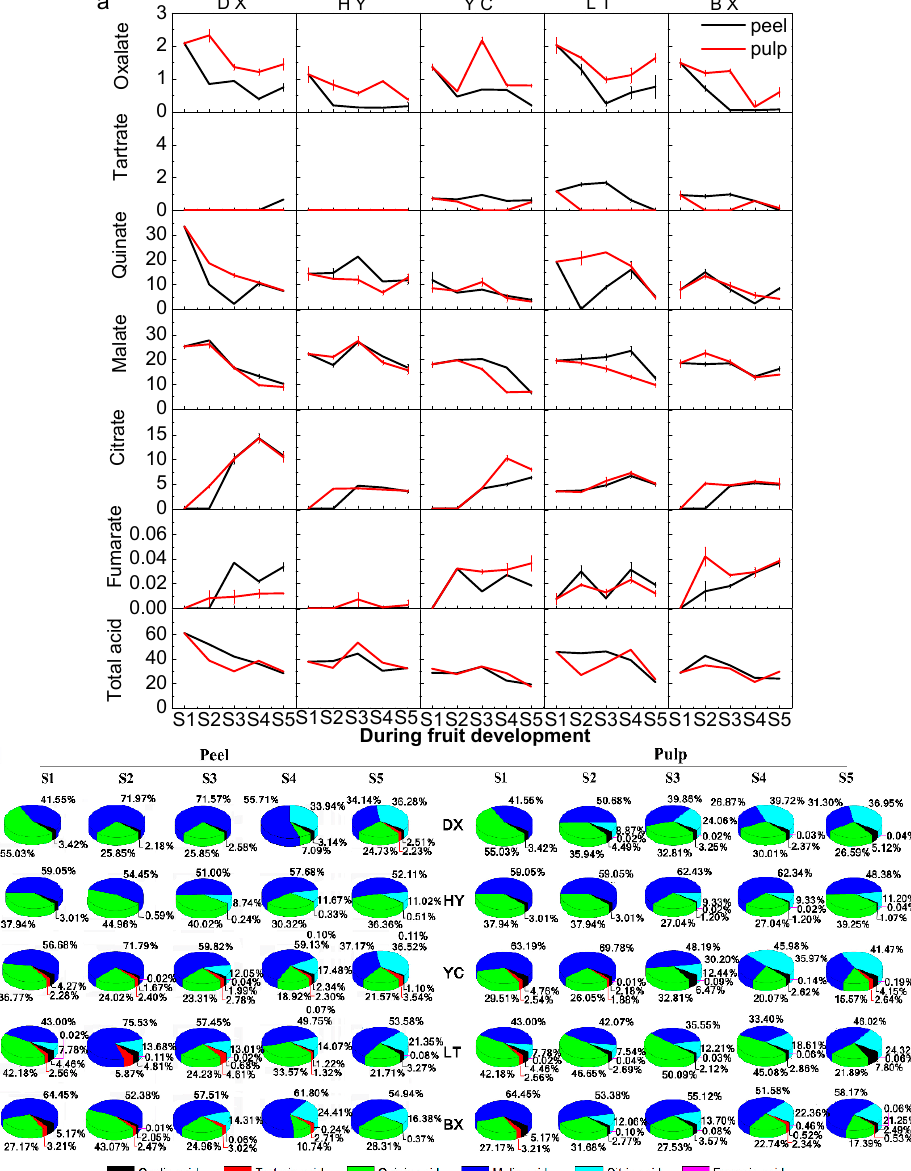
Figure 4. Organic acid content (mg/g FW) and ratio in apricot fruit during development and ripening. ( a ) Changes in organic acids; ( b ) The ratio of individual organic acid content to total organic acids content. Two capital letters in the middle are the cultivars shown in Table 1. All data are expressed as means ± standard error of triplicate samples.